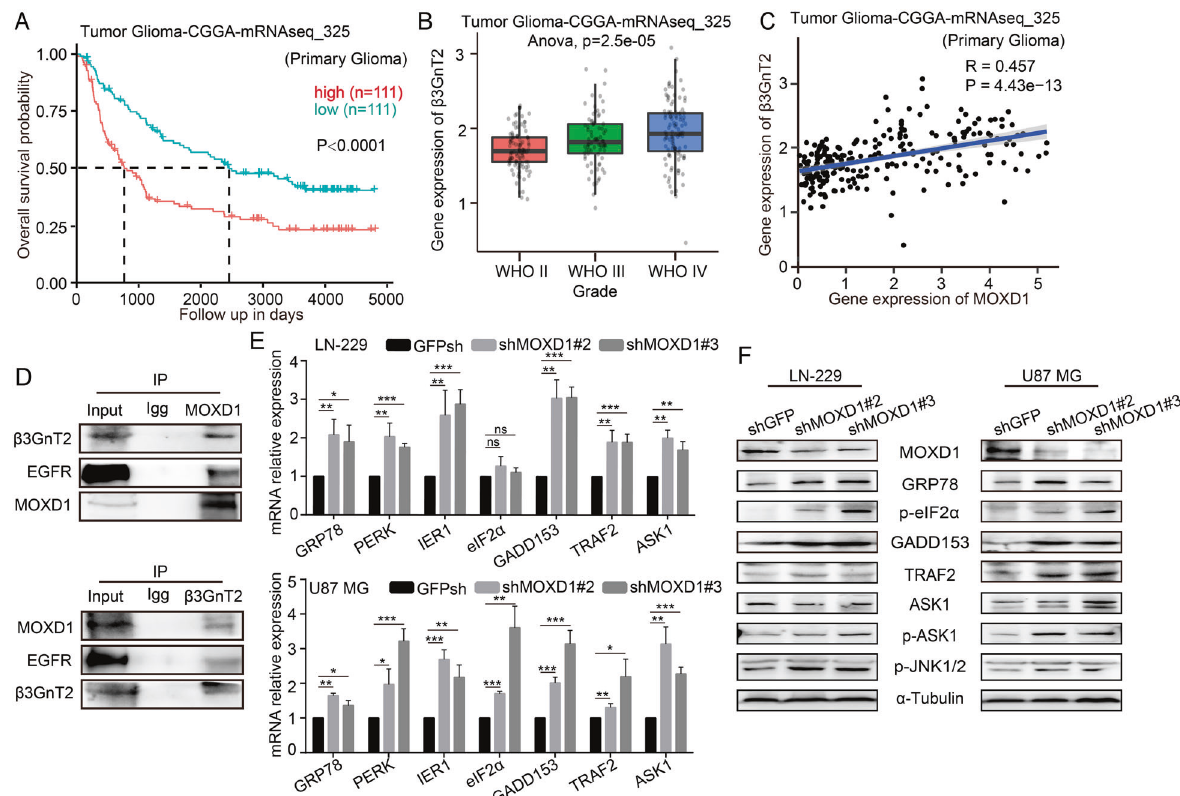
Fig. 6 Blocking MOXD1 can trigger ER stress to induce GBM cell apoptosis. A Results of the Kaplan – Meier analysis of progression-free survival and the log-rank test p values are indicated for tumor glioma-CGGA-mRNAseq-325. B Box plot of β 3GnT2 expression levels in grade II – IV gliomas in tumor glioma-CGGA-mRNAseq-325. C Correlation between MOXD1 and β 3GnT2 form tumor glioma-CGGA-mRNAseq-325. D IP proved the protein interaction between MOXD1 and β 3GnT2. E The expression of ER stress-related genes was detected using qRT-PCR. F The expression of ER stress-related proteins was detected using Western